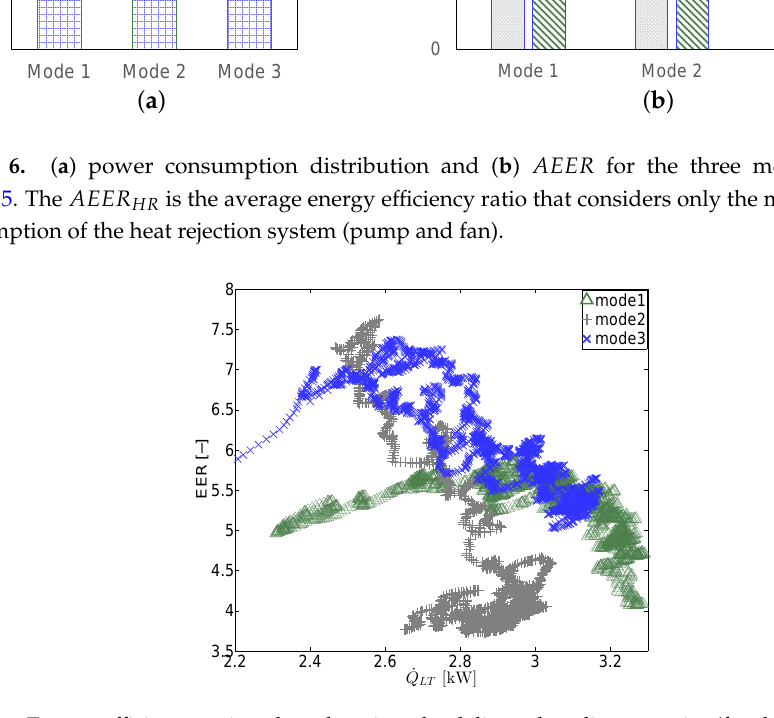
Figure 7. Energy efficiency ratios plotted against the delivered cooling capacity (for the three example days). For the sake of clarity, the EER values have been averaged over 5 min.